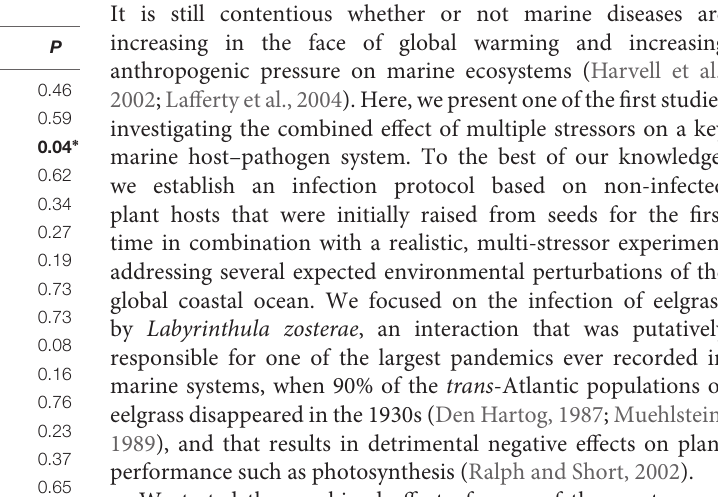
TABLE 2 | Generalized linear mixed model results for eelgrass extract inhibition capacity on Labyrinthula zosterae growth according to experimental treatments from which eelgrass shoots were exposed to during experiment.